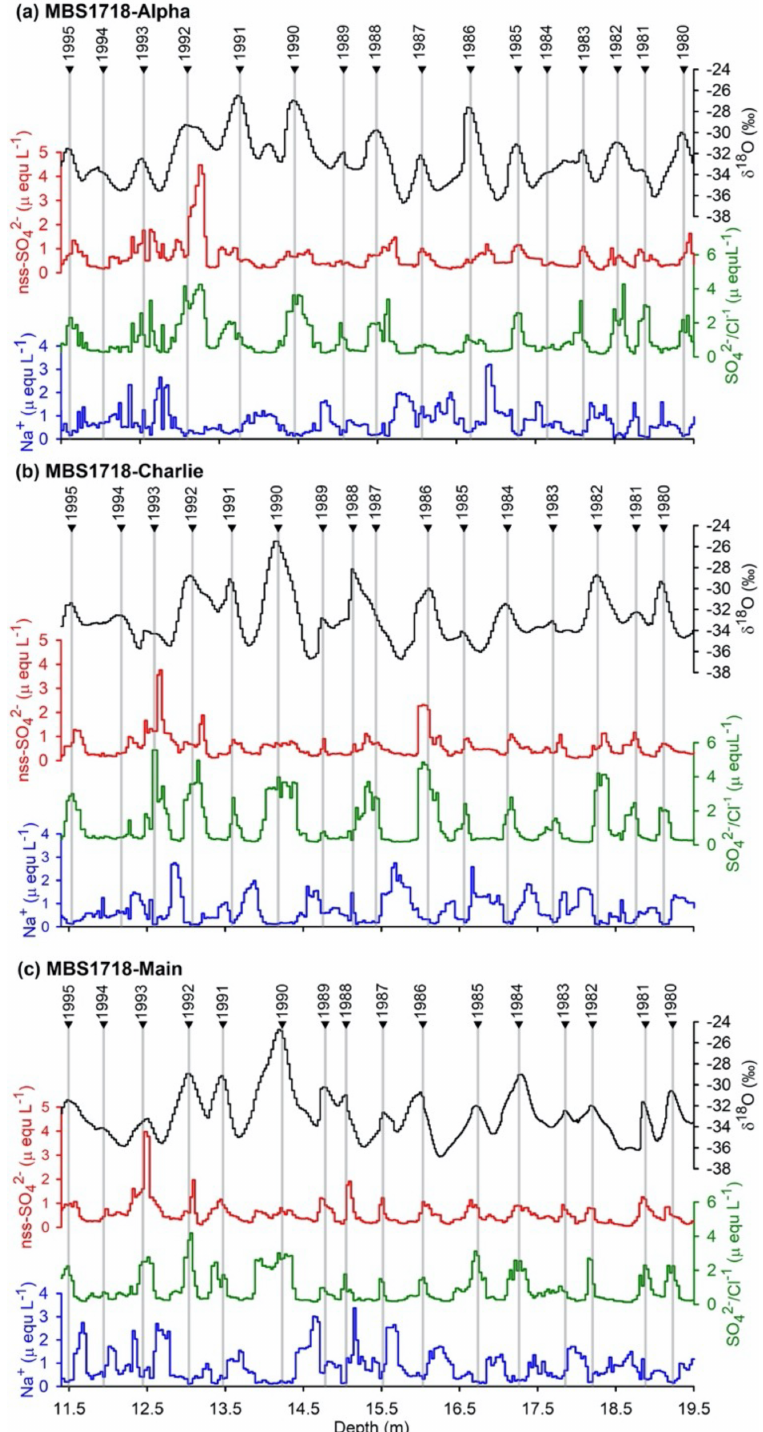
Figure 2. An 8m long section from the Mount Brown South ( a MBS1718-Alpha, b MBS1718-Charlie, and c MBS1718-Main) ice cores. These sections cover the period 1980–1995 (which contains some ambiguous annual horizons; see Sect. 3.1), with annual layers (year boundaries) shown as triangles with vertical grey lines. Annual horizons are identified from summer-peaking glaciochemical species, i.e. / Cl − ). Winter-peaking sea salts oxygen isotopes ( δ 18 O), non-sea-salt sulfate (nssSO 2 − ) and the ratio between sulfate and chloride (SO 2 − 4 4 (Na + ) are used as a confirmatory species. Panels (a) and (b) are on the same depth scale as shown in (c)